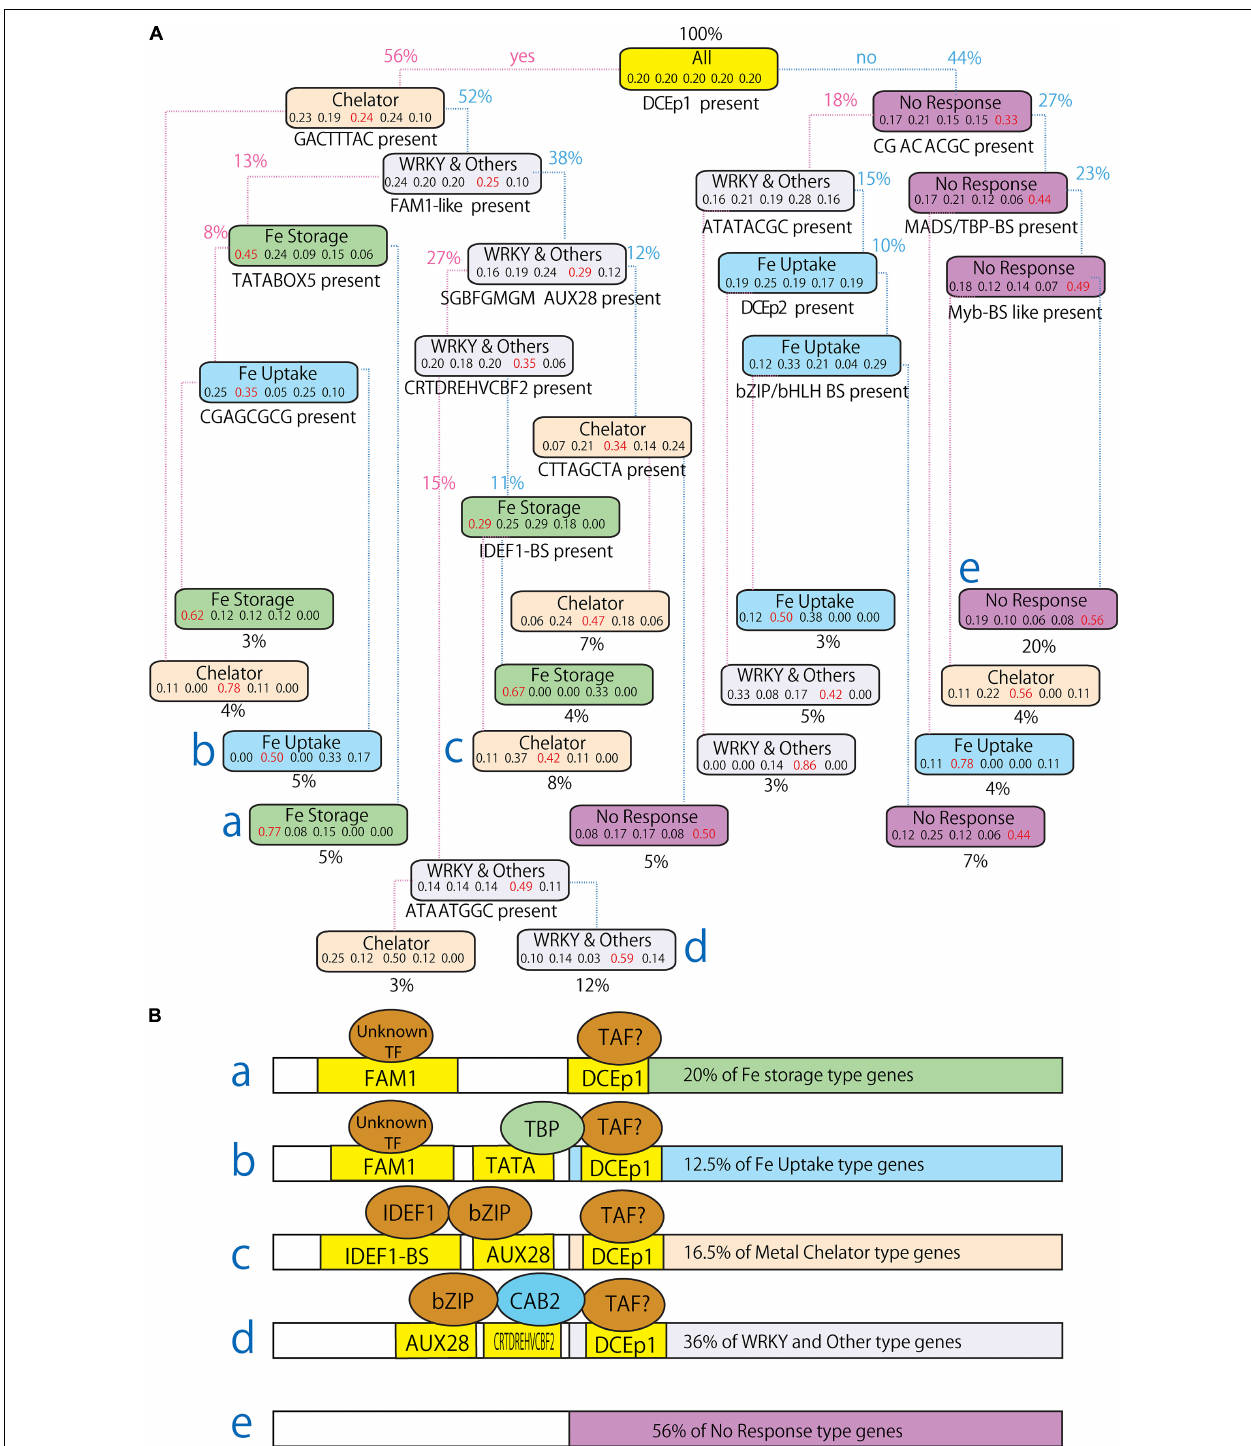
FIGURE 7 | Hypothetical model revealing the underlying Fe excess-responsive transcriptional regulation. (A) Simple tree model and YES-NO-Flowchart to explain Fe excess-responsive gene expression patterns. CRE candidate motifs were searched in the regions –500 bp to +150 bp relative to TSS of genes to classify gene expression patterns and each gene is divided by YES or NO flowchart by whether specific CRE candidate motifs described under the box is present or not. The percentage side of the flowchart line indicates the percentage of genes which present (YES) or absent (NO) the CRE shown above. The five numbers shown in